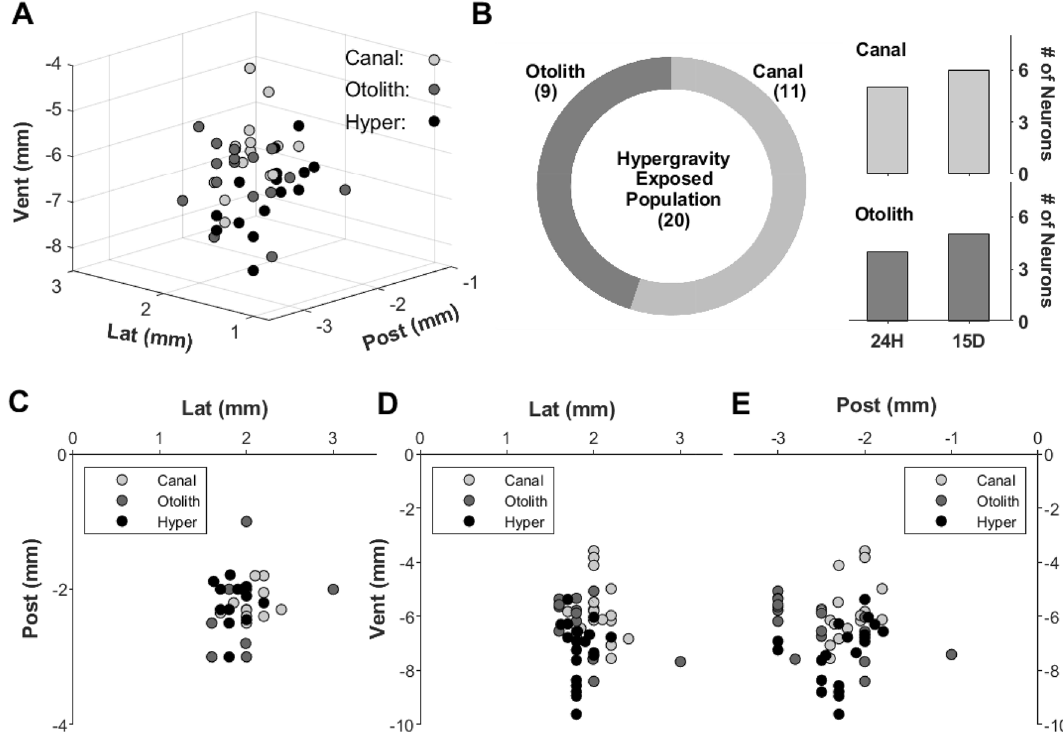
Figure 1. 3D recording positions for extracellular neuronal activities ( A ) and the recorded population distribution, depending on the neuronal responses to kinetic stimulations ( B ). 2D recording positions were provided from different aspects of